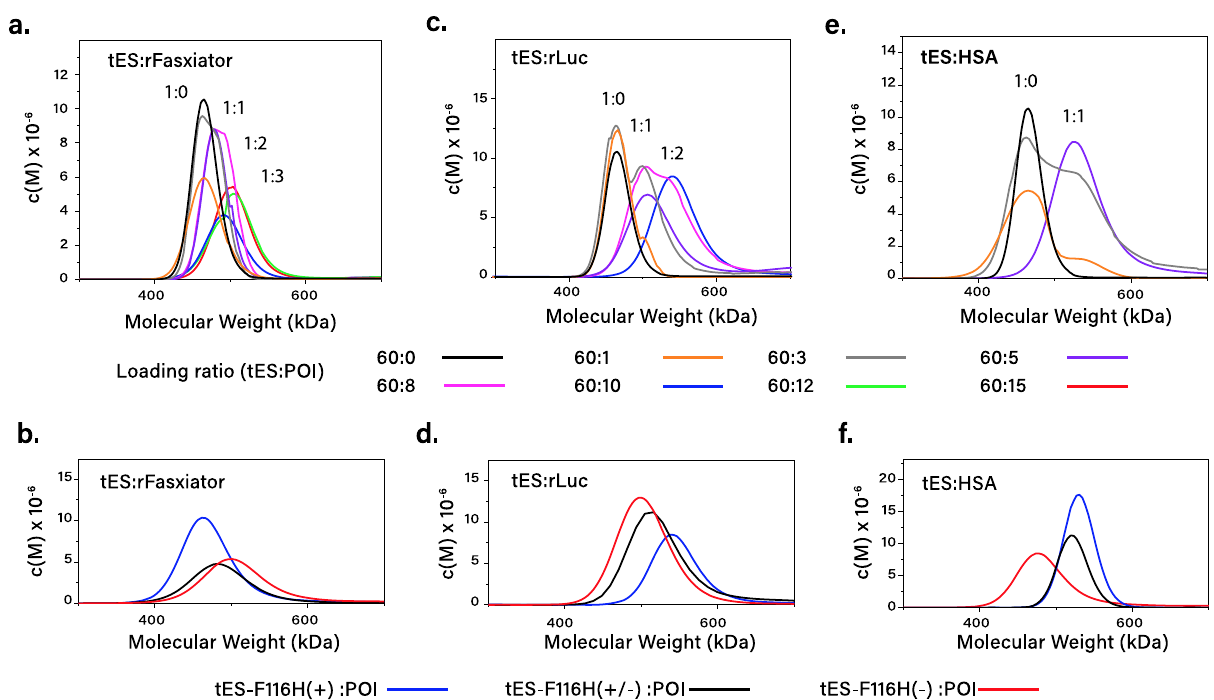
Fig. 3 Monomeric POI encapsulation using tES – F116H. a tES – F116H can encapsulate three rFasxiator molecules (36 kDa, total, loading ratio of 60:15) (AUC peaks are labeled with the number of encapsulated POI with colors corresponding to the molar ratios of titrated POI during the folding protocol). b tES – F116H charge is a critical determinant of encapsulation ef fi ciency. Positively charged rFasxiator exhibits no encapsulation in tES – F116H( + ). c Two rLuc molecules (72 kDa, total, loading ratio of 60:10) can be accommodated in tES – F116H. d Negatively charged rLuc shows optimal encapsulation in tES – F116H( + ). e tES accomodates one HSA (66 kDa, total, loading ratio of 60:5) molecule. f Negatively charged HSA shows optimal encapsulation in tES – F116H( +